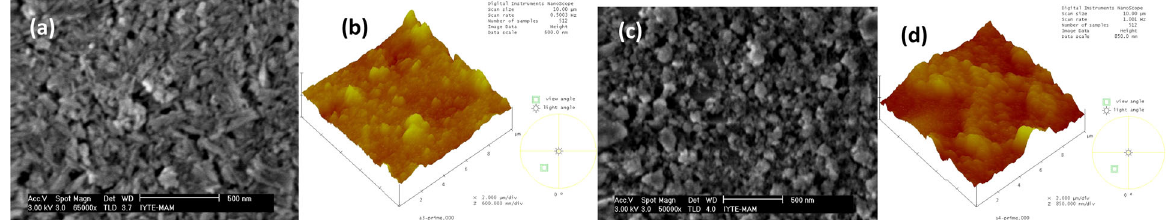
Fig. 5 The SEM and AFM images of the c-HAp and m-HAp fi lms (with 15w% solid content suspension) on the glass/sericin substrate ( a ) the SEM image of c-HAp fi lm, 65,000x, ( b ) the AFM 3-dim.